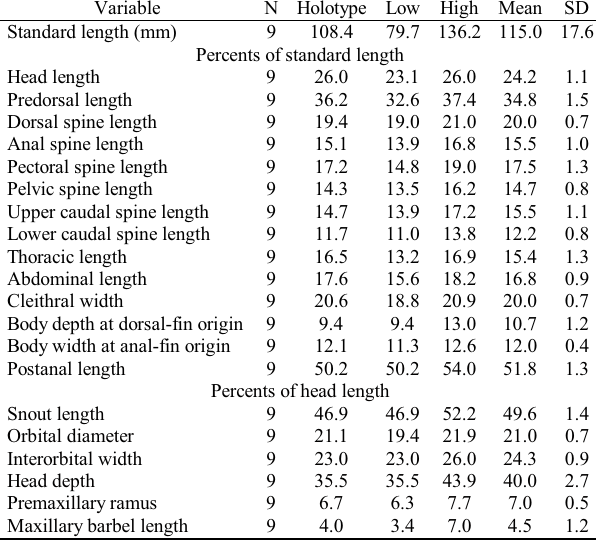
Table 2. Morphometric data of Rineloricaria maacki from middle and lower rio Iguaçu. N = sample size; SD = Standard deviation. Range includes the